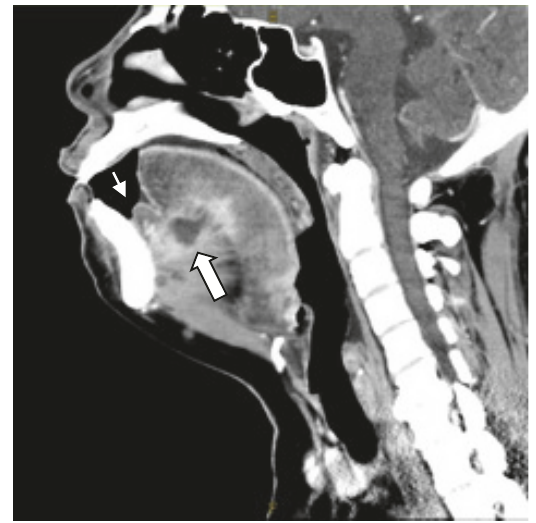
Figure 1: Contrast-enhanced CT scan showed the abscess confined at the ventral aspect of the tongue with sublingual space cellulitis (thick arrow) and marked swelling of anterior floor of mouth was demonstrated (thin